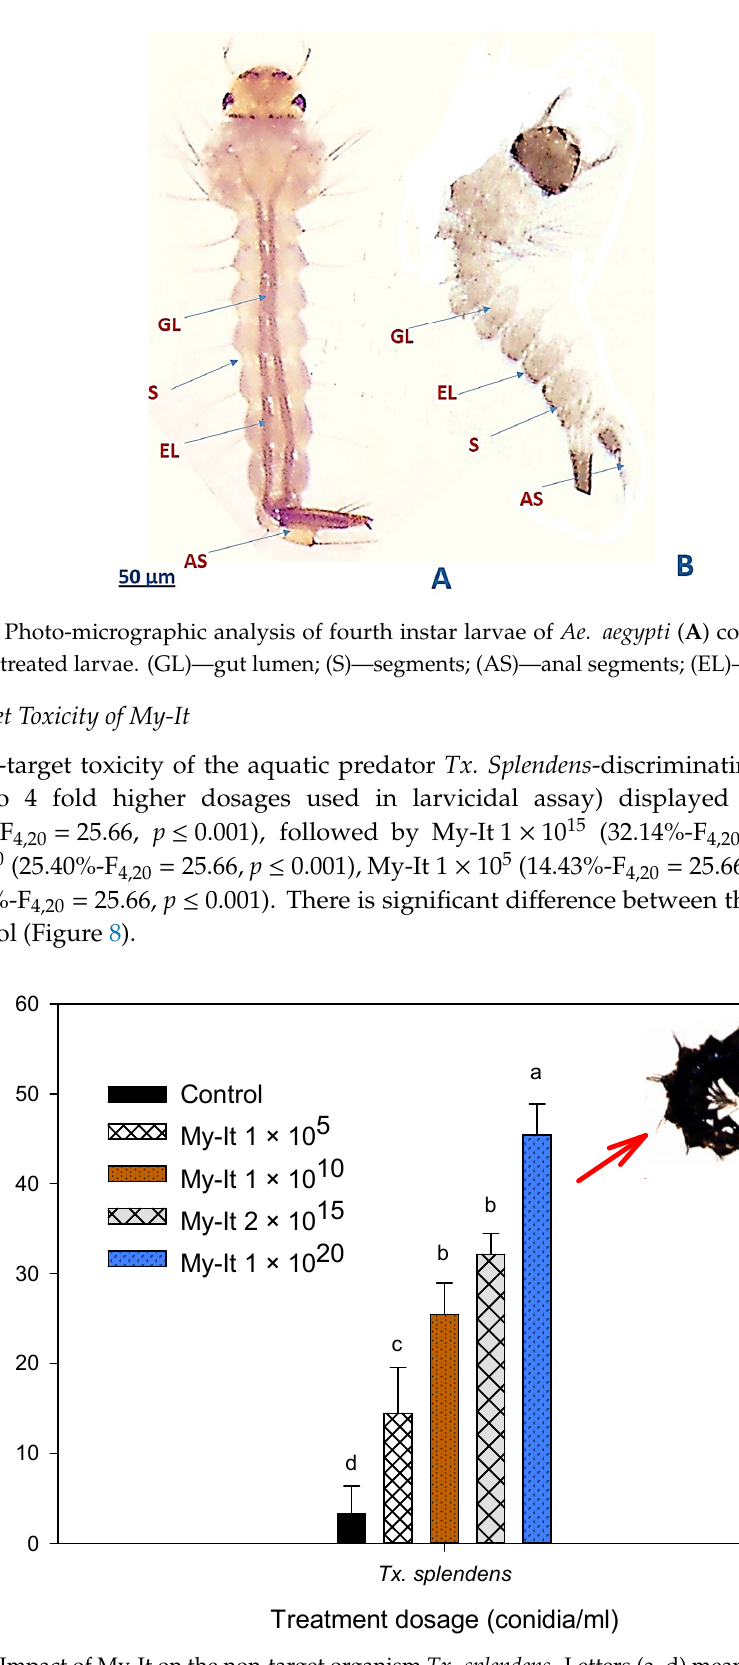
Figure 8. Impact of My-It on the non-target organism Tx. splendens . Letters (a–d) mean ( ± SE) followed by the same letters above bars indicate no significant difference ( p ≤ 0.05) using Probit analysis.